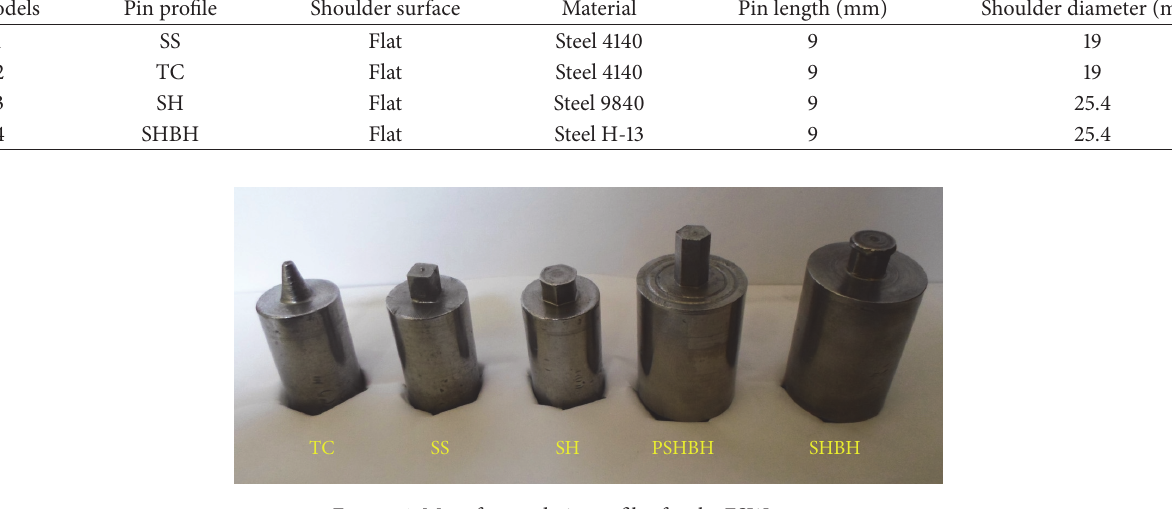
Figure 1: Manufactured pin profiles for the FSW process.